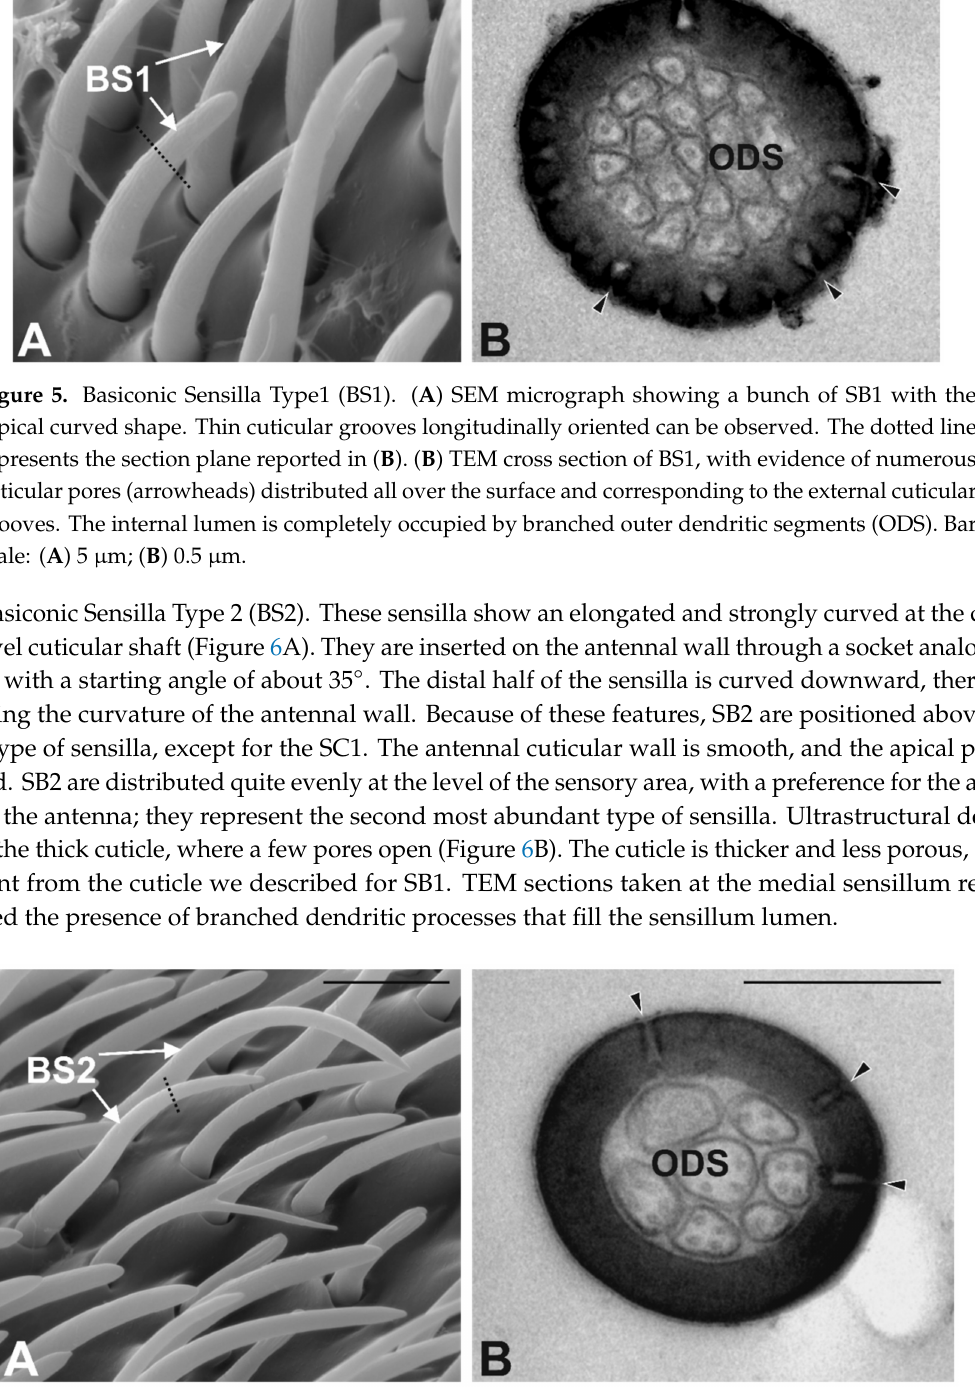
Figure 6. Basiconic Sensilla Type2 (BS2). ( A ) SEM micrograph showing BS2 sensilla, appearing longer than the surrounding sensilla and distinctly curved. Dotted line corresponds to the TEM section plane. ( B ) TEM micrograph showing a cross section of BS2. The cuticle is thick and perforated by few pores (arrowheads). The sensillum lumen is filled by branched outer dendritic segments (ODS). Bar scale: ( A ) 5 µ m; ( B ) 0.5 µ